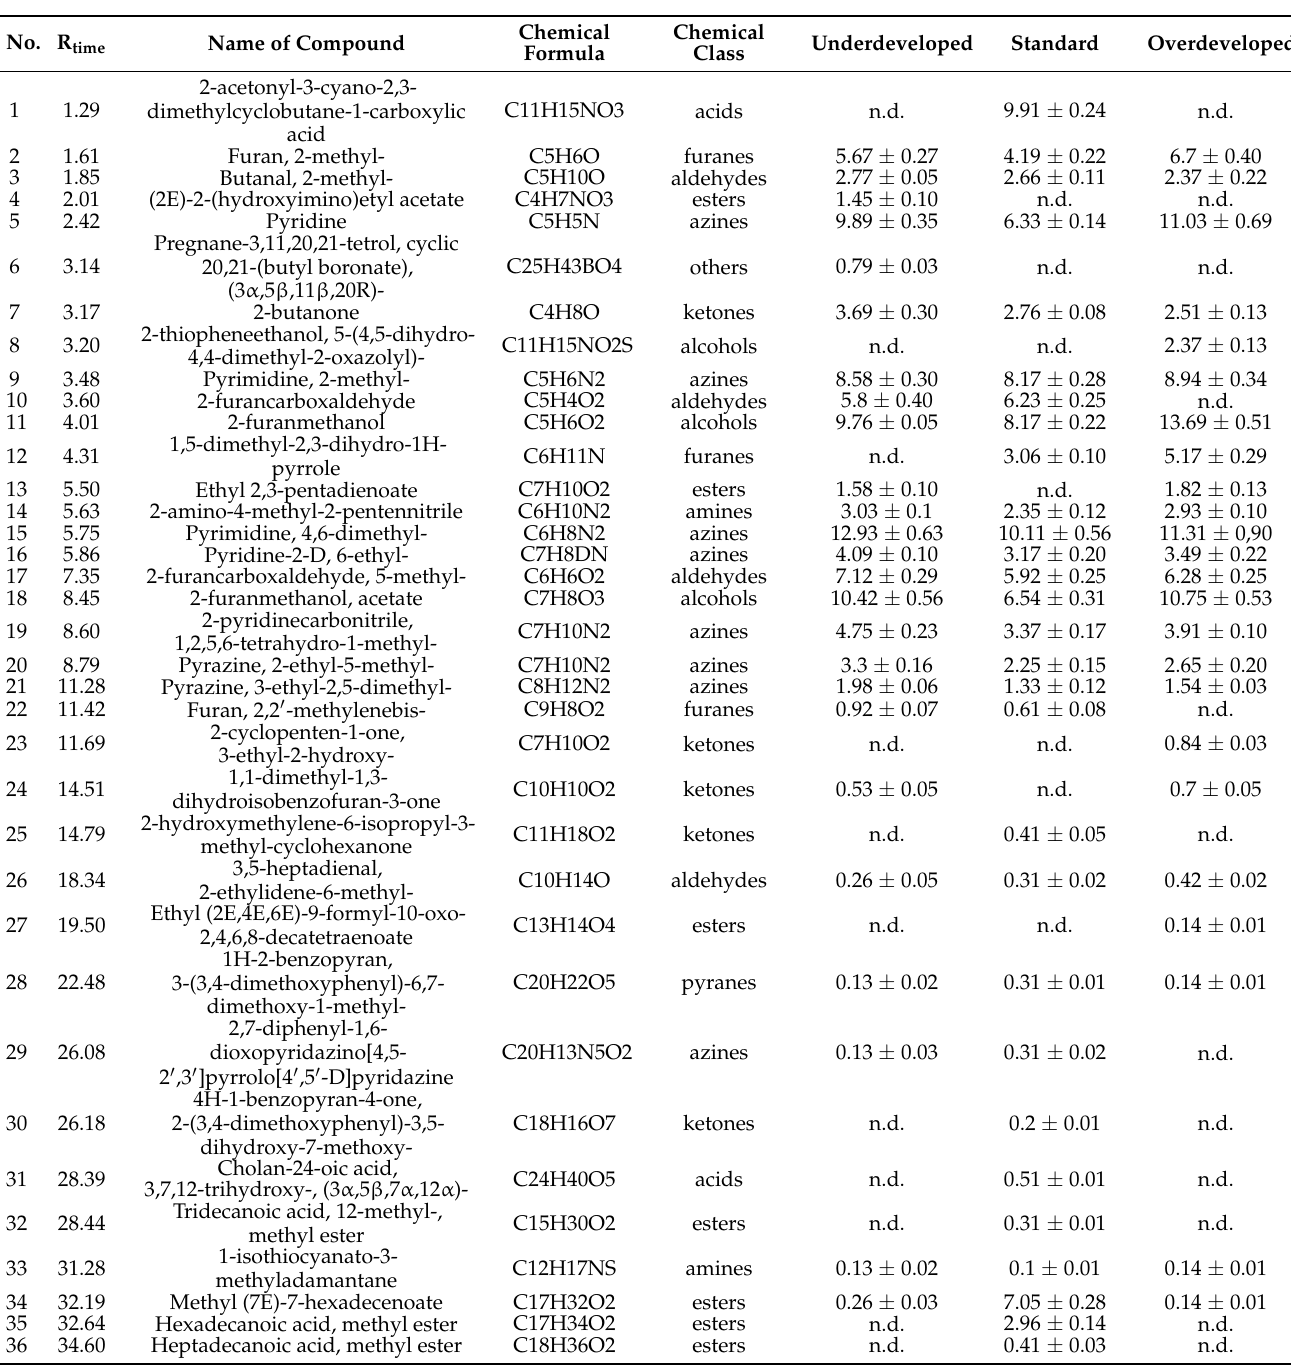
Table 2. Volatile compounds determined in the chromatographic analysis. %—percentage share of the compound with standard deviations in the tested sample immediately after roasting of underde- veloped, standard, and overdeveloped